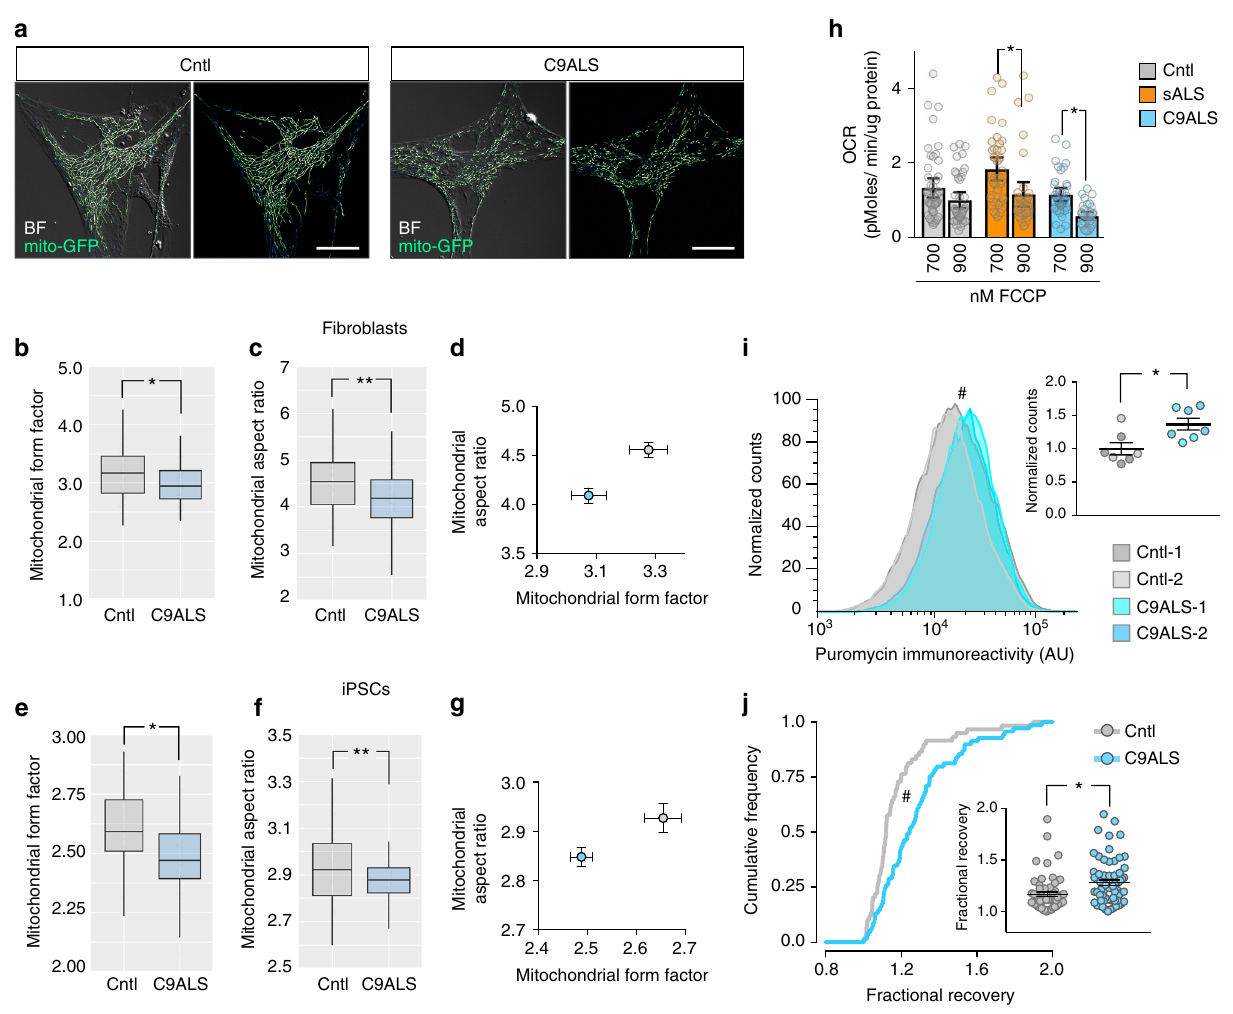
Fig. 8 Mitochondria morphology and protein synthesis in ALS patient-derived cells. a Mitochondrial morphology in control (Cntl) and C9ALS fi broblasts expressing mito-GFP. BF bright fi eld. Scale bars = 20 µ m. Mitochondrial form factor (a measure of mitochondrial complexity, b ) and aspect ratio (an estimate of circularity, c ), or both ( d ) in fi broblasts expressing mito-GFP. Morphological analysis of mitochondrial form factor ( e ), aspect ratio ( f ), or both ( g ) in iPSCs stained with the mitochondrial dye TMRE. * p < 0.05, ** p < 0.001 by one-way ANOVA with Tukey ’ s test. n > 20 cells/group. Results in b − d were combined from four lines each of control and C9orf72 fi broblasts, while e , f were combined from two lines each of control and C9orf72 iPSCs, performed in duplicate. Plots in b , c , e , f show median (horizontal line), interquartile range (box) and maximum/minimum (vertical lines). Graphs in d and g show mean ± standard error. h Bioenergetics analyses demonstrated greater reductions in oxygen consumption rate (OCR) upon addition of 900 nM FCCP, a decoupling agent, to C9ALS and sALS fi broblasts in comparison to controls. n = 8 (Control), 8 (sALS), and 7 (C9ALS) lines/group, as described in Supplementary Table 1. Plot in h shows mean ± 95% con fi dence interval. i iPSCs from controls and patients carrying C9orf72 mutations displayed elevated protein synthesis by SUnSET. * p < 0.01 by two-sided Kolmogorov − Smirnov test. Inset shows a scatter plot of normalized anti-puromycin counts (mean ± standard error) from control and C9orf72 mutant iPSCs. * p = 0.0129, unpaired t test. n = 2 lines each of control and C9ALS iPSCs, in three separate replicates. j Cumulative distribution function for fractional recovery of mCherry fl uorescence in control and C9orf72 iPSCs at 3.5 h. * p < 0.01,